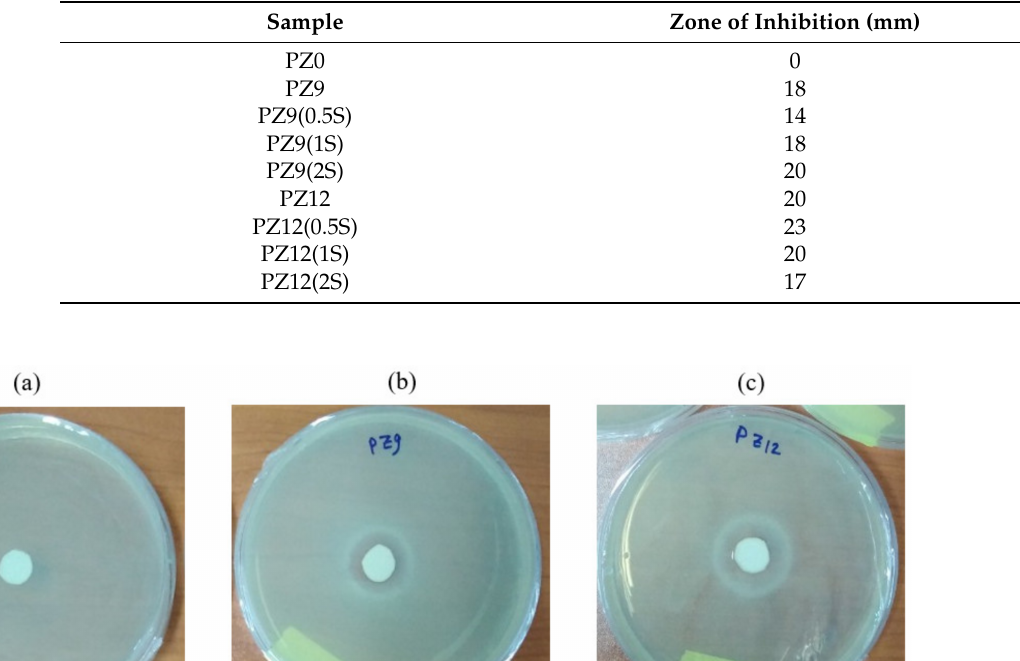
Table 7. Zone of inhibition of nanofibers prepared with intrinsic and silane-modified ZnO NPs.